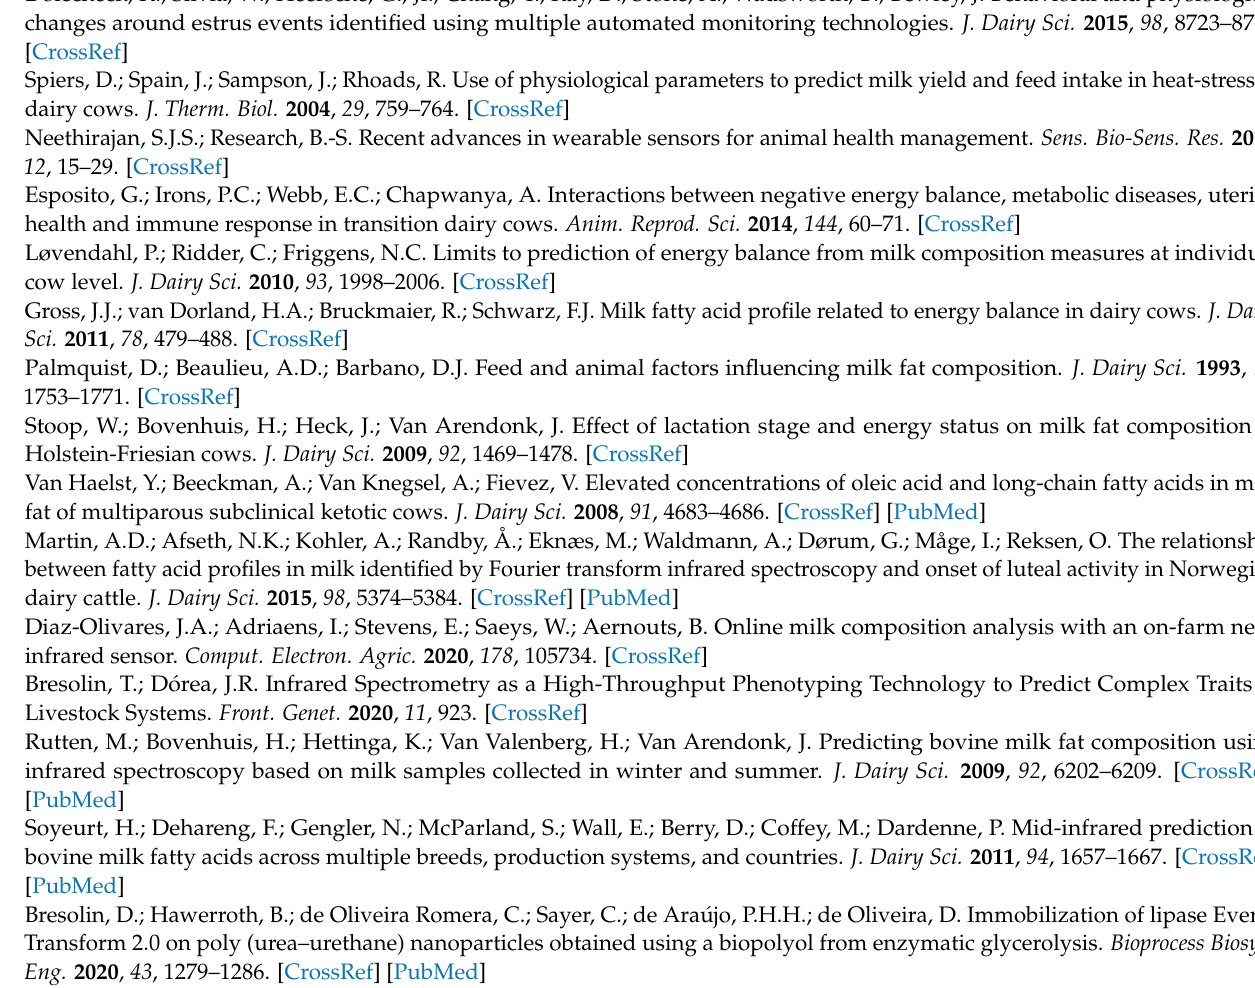
DIM1 vs. DIM2. Table S5. Classification results: 826 samples of PAR > 2 group classified by SPLSDA model as DIM1 vs.